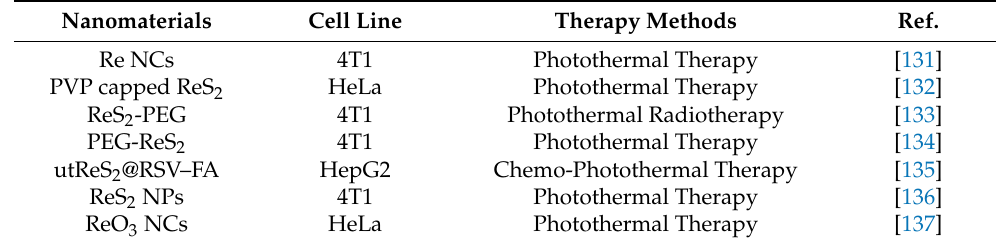
Table 2. Therapy methods of rhenium inorganic nanomaterials and cancer cell lines they act on. Nanomaterials Cell Line Therapy Methods Ref. Re NCs 4T1 Photothermal